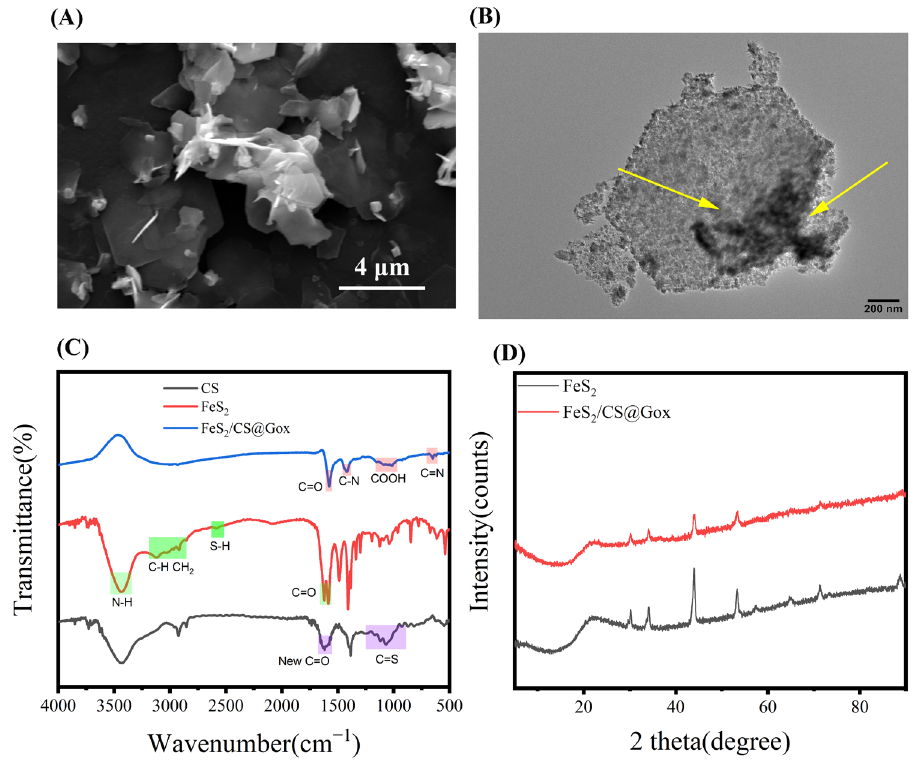
Figure 1. ( A ) The SEM picture of FeS 2 /CS@Gox. ( B ) The TEM picture of FeS 2 /CS@Gox (The yellow arrow points to the attachment on FeS 2 ). ( C ) The FTIR of CS, FeS 2 and FeS 2 /CS@Gox. ( D ) The XRD pattern of FeS 2 and FeS 2 /CS@Gox.